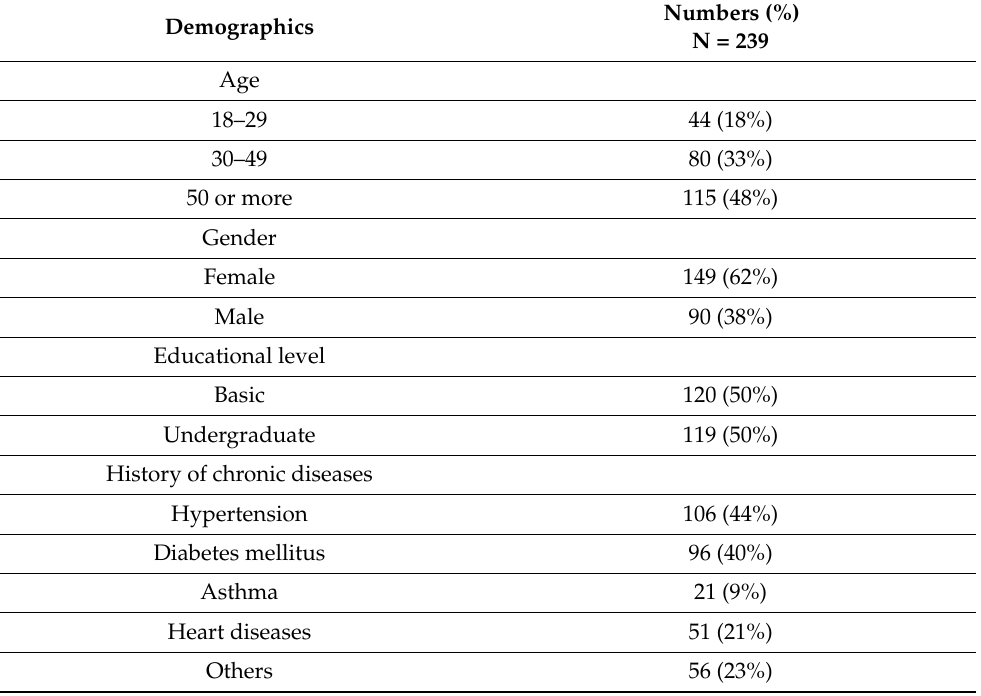
Table 2. Demographic characteristics of participants.